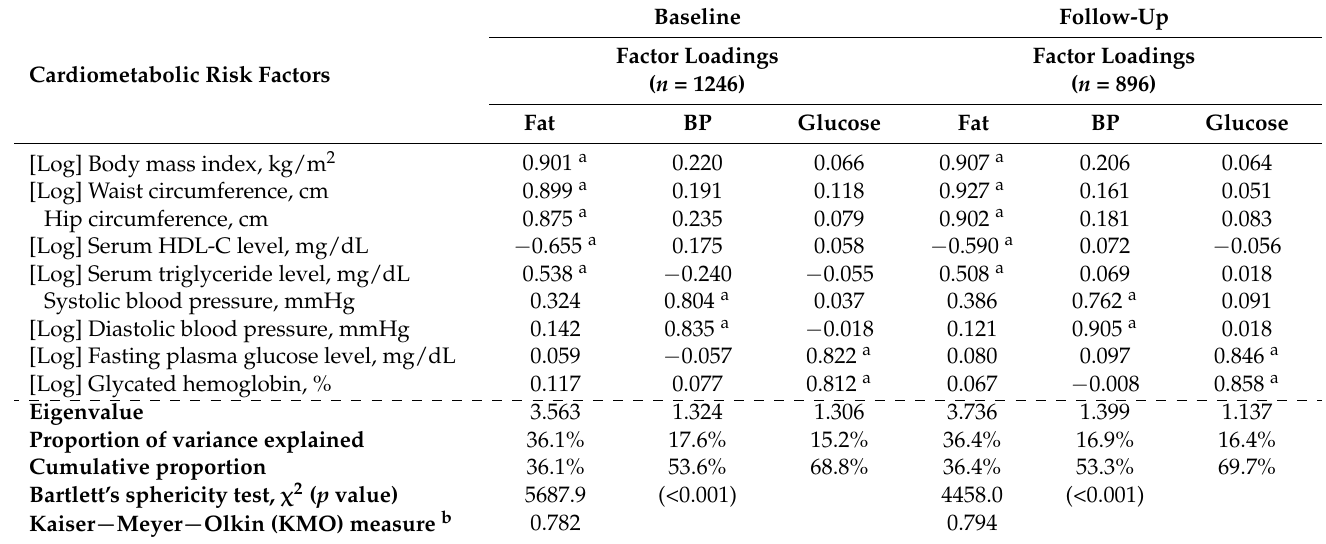
Table 2. Exploratory factor analysis-derived factors, factor loadings, and proportions of variance explained for cardiometabolic risk factors measured at baseline and follow-up in adolescents.